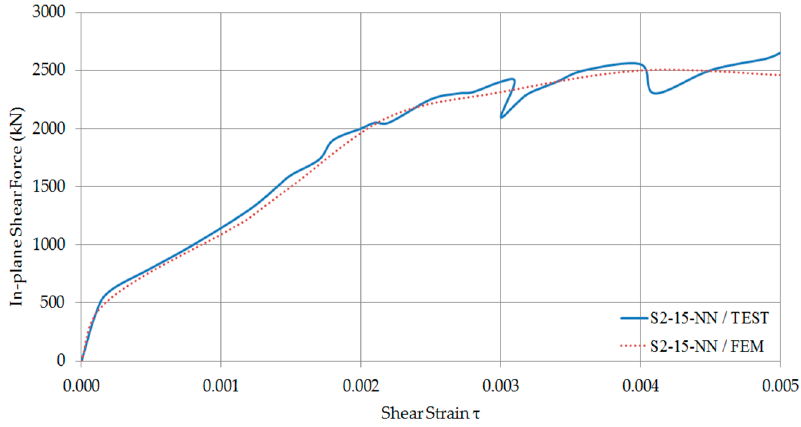
Figure 16. In-plane shear force—Shear strain Curves of S2-15-NN.